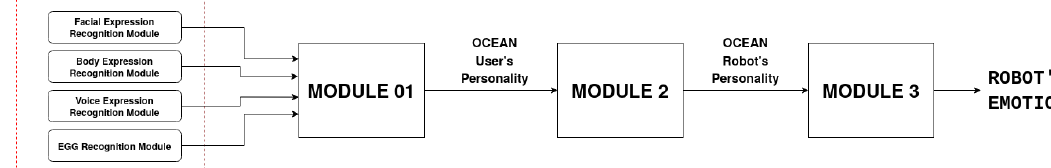
Figure 2. Inference of an Emotional State (I2E) architecture overview.